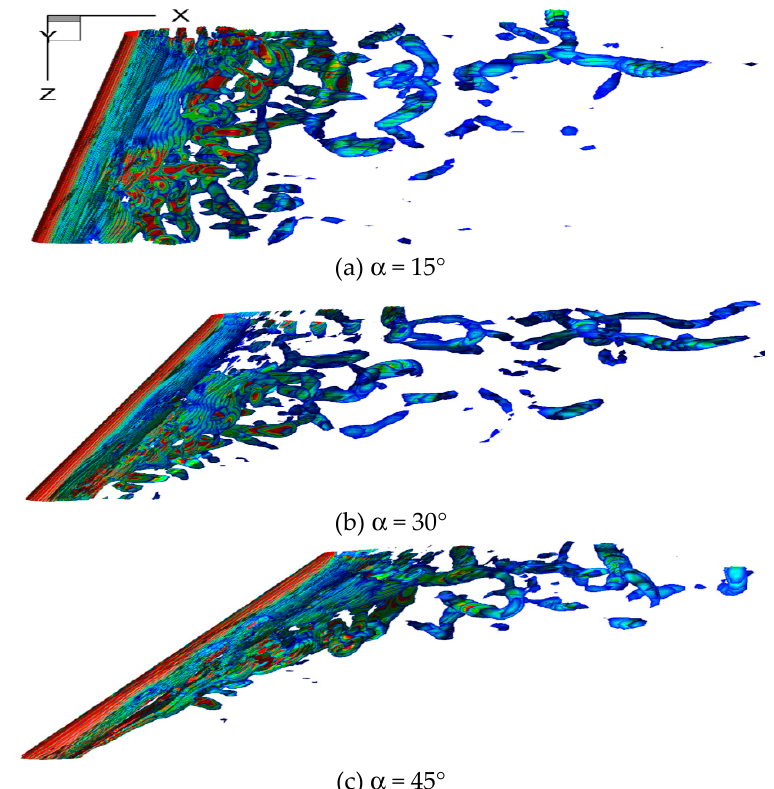
Figure 5. Vortex structure under nonslip boundary condition of two end-plate walls.